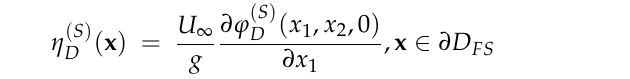
Figure 5. ( a ) Color plot and ( b ) rendered view of the free surface elevation generated by the steady perturbation field for four cylindrical scatterers of diameter